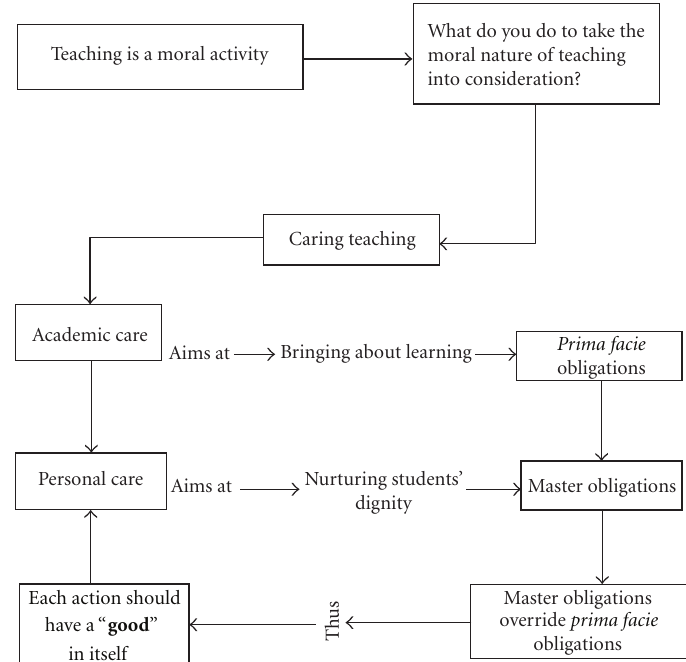
Figure 1: Moral nature of teaching practice.